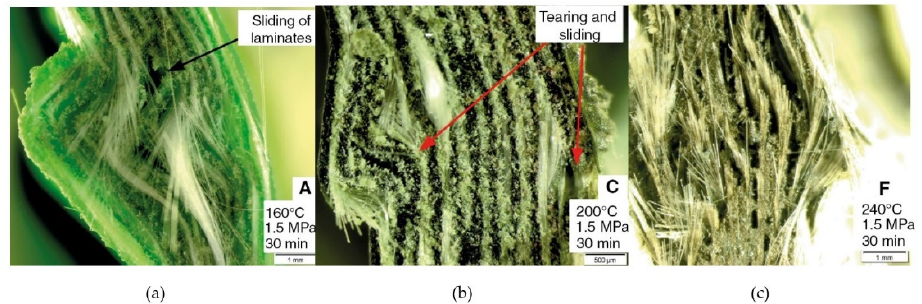
Figure 5. Failure mechanism in GF-PVC laminate as a function of processing temperature: ( a ) 160 °C, ( b ) 200 °C, ( c ) 240 °C. Adapted with permission from Reference [27].